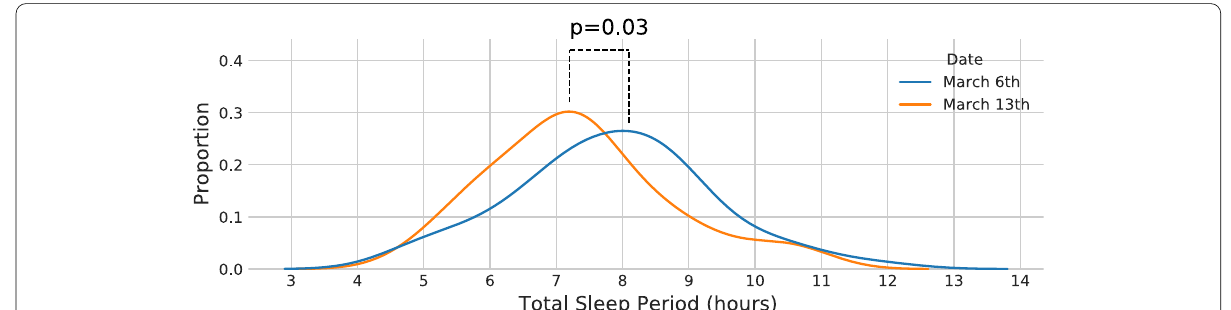
Fig. 4 Line graphs representing TSP distributions before (blue) and after (orange) the DST transition in the cohort of study participants ( N 59). Average TSP was 7 h and 51 min before the DST transition (blue curve), and 7 h and 21 min after the transition (orange curve), indicating = an average reduction of 29.6 min (Wilcoxon signed-rank test p =